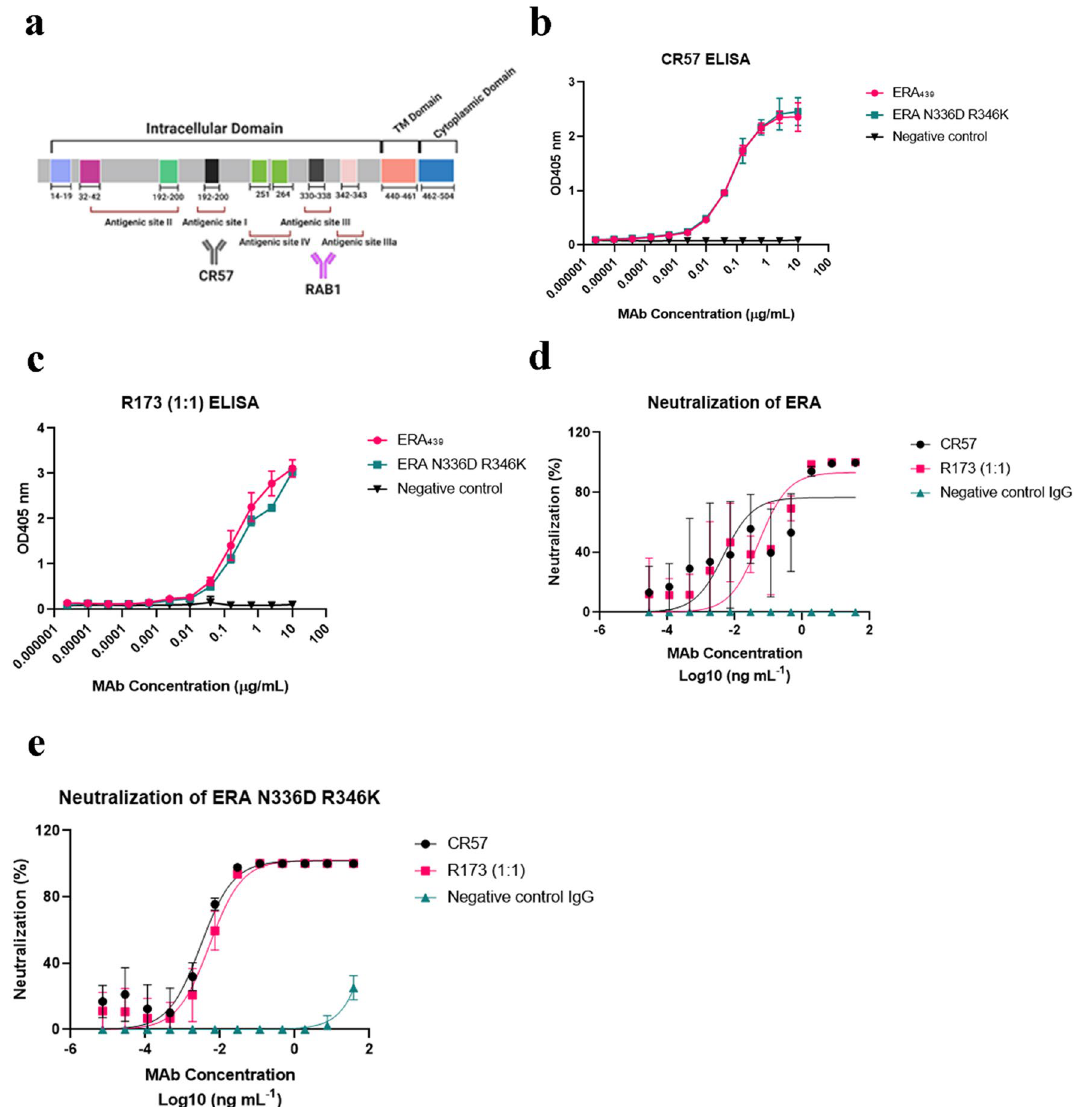
Figure 2. CR57 and R173 binding and neutralization of rabies glycoproteins. ( a ) Schematic of rabies glycoprotein showing non-overlapping antigenic sites locations of RAB1 (antigenic site III) and CR57 (antigenic site I), figure was created with BioRender.com. ( b , c ) ELISA binding of CR57 ( b ) and R173 ( c ) to the wild type ERA 439 or RAB1 escape mutant N336D R346K. ( d , e ) Pseudovirus neutralization of RAB1, CR57, and R173 against lentivirus bearing the wild type ERA glycoprotein ( d ) and N336 R346K mutant ( e ). EC 50 values were calculated by nonlinear regression analysis using Prism version 8.1.1. Data is plotted as the mean ± s.d. from n = 4 independent